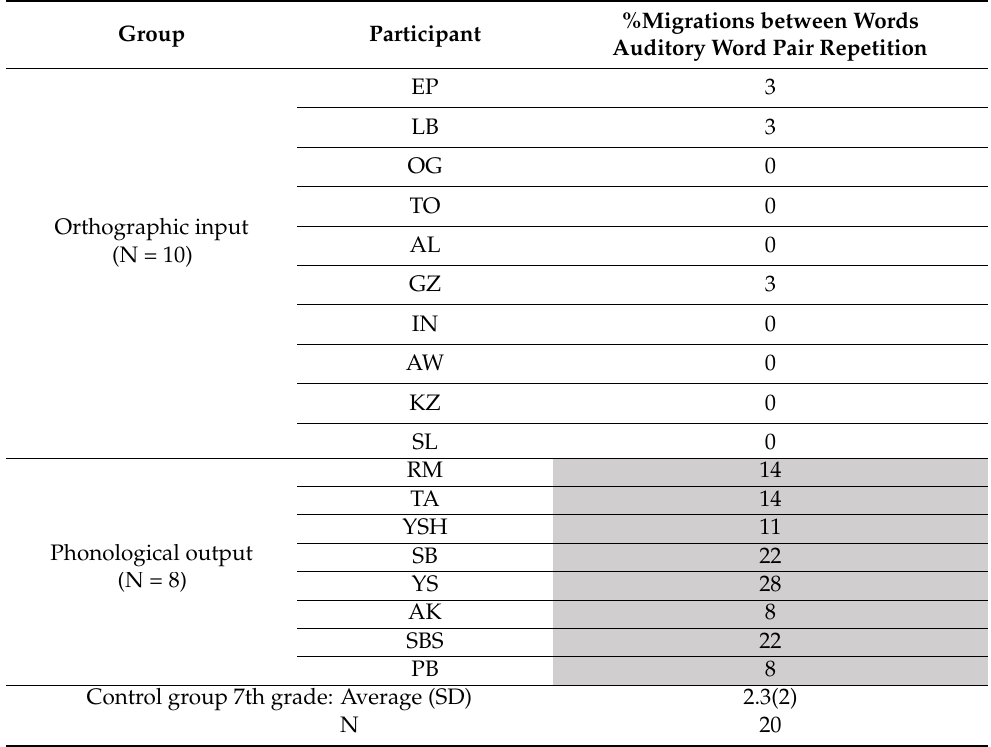
Table 3. Word pair repetition (NADNEDA test): Percentage of migrations between words out of the number of word pairs the participant repeated.